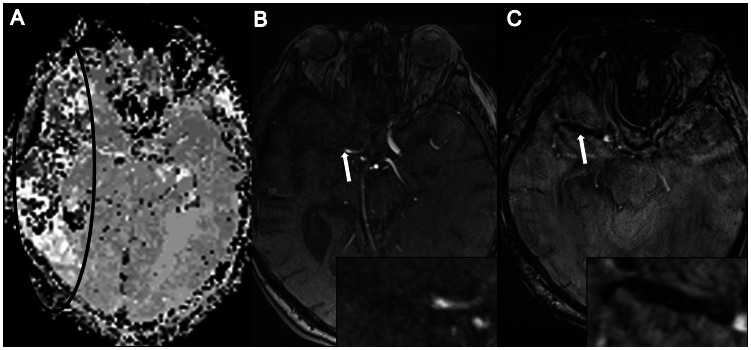
Patient with acute right-hemispheric-stroke.Time-to-peak perfusion map (A) displays impaired perfusion in the area of the right middle cerebral artery (MCA), while TOF-angiography demonstrates occlusion of the right MCA in the M1 segment (B). Typical appearance of a Susceptibility vessel sign (SVS) on SWI is shown in (C).